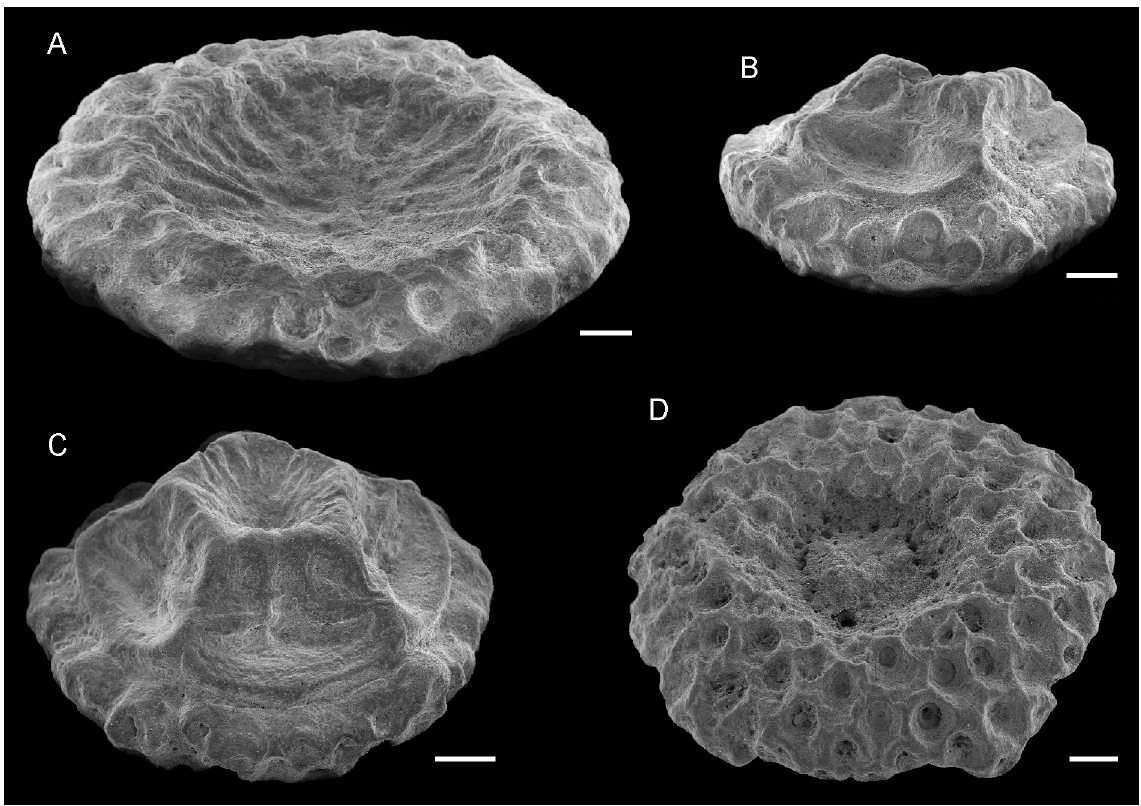
Fig. 6. Calices of Discometra rhodanica (Fontannes, 1877) from Picabrier. A . Aboral oblique view of centrodorsal, largest specimen (MHNL 20.062686). B . Adoral oblique view, smallest specimen (MHNL 20.062688). C–D . Specimen of intermediate size (MHNL 20.062687). C . Adoral oblique view. D . Aboral oblique view. Scale bars = 1